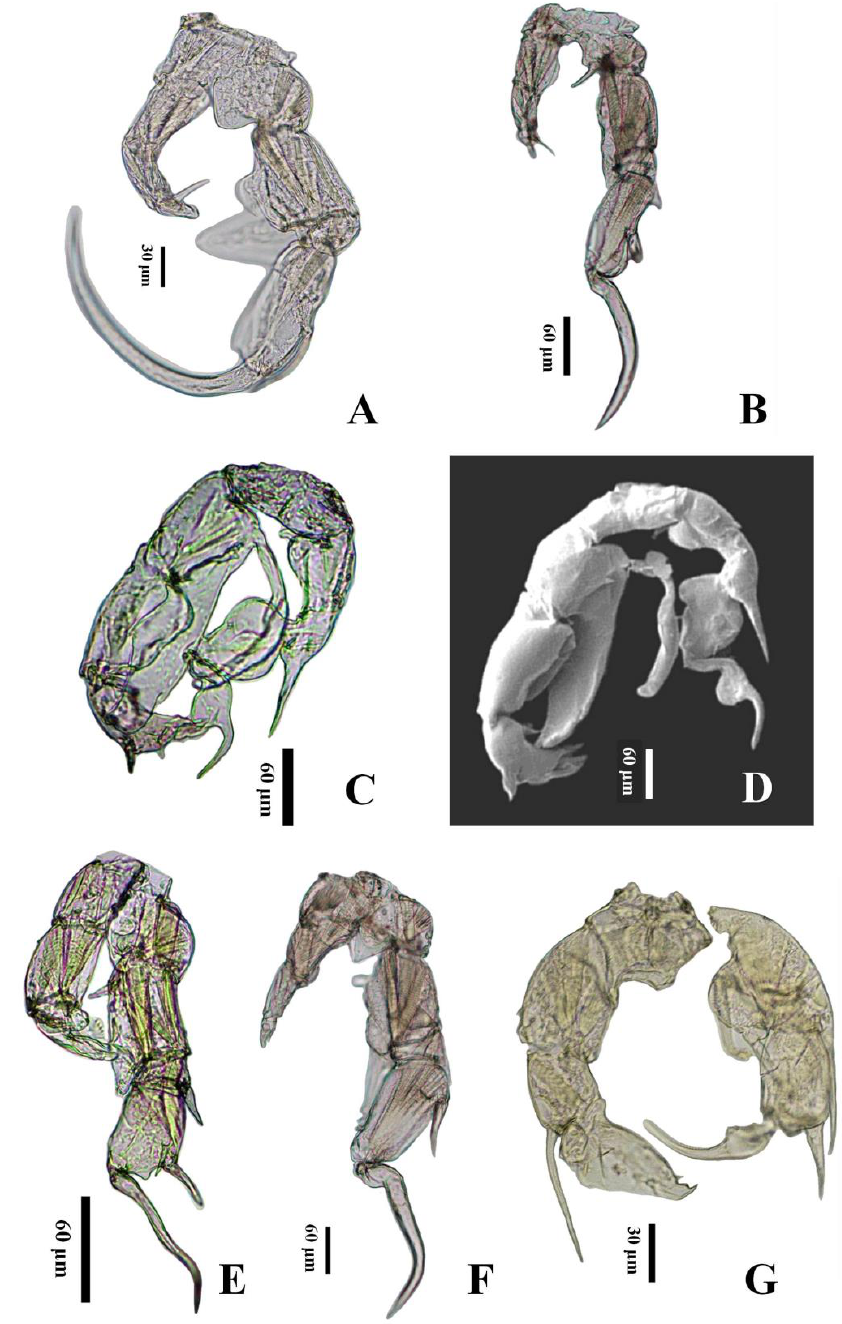
Figure 2. Photographs of the male leg 5 (P5) of calanoid copepods recorded in Vietnam: Mongolodiaptomus malaindosinensis ( A ), Mongolodiaptomus mekongensis ( B ), Pseudodiaptomus siamensis ( C , D ), Tropodiaptomus sp. ( E ), Vietodiaptomus blachei ( F ), and Pseudodiaptomus dauglishi ( G ).